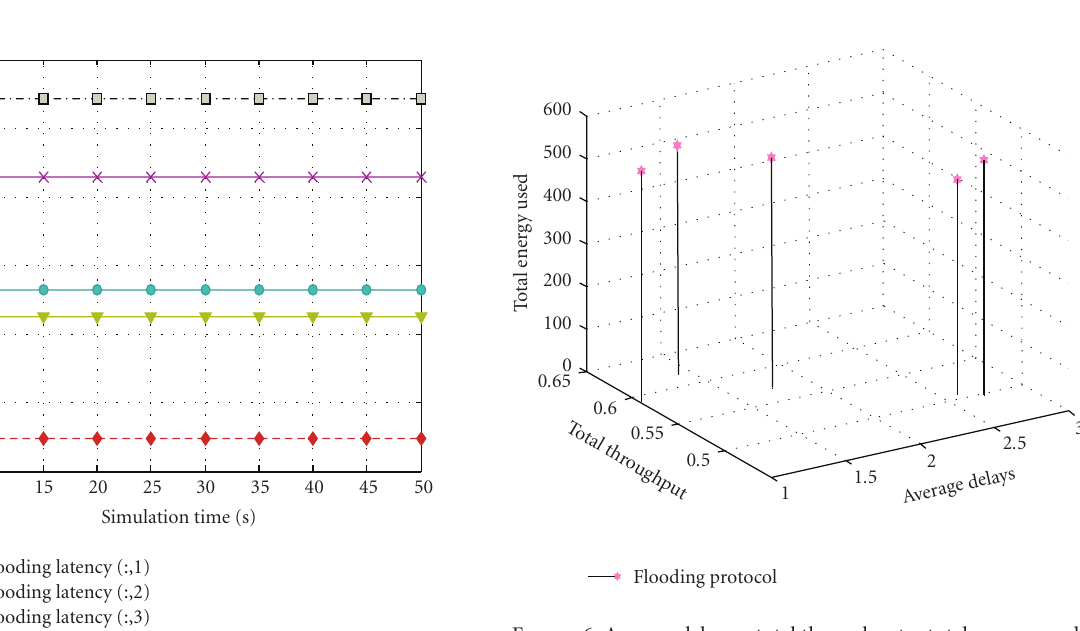
Figure 6: Average delays—total throughput—total energy used.